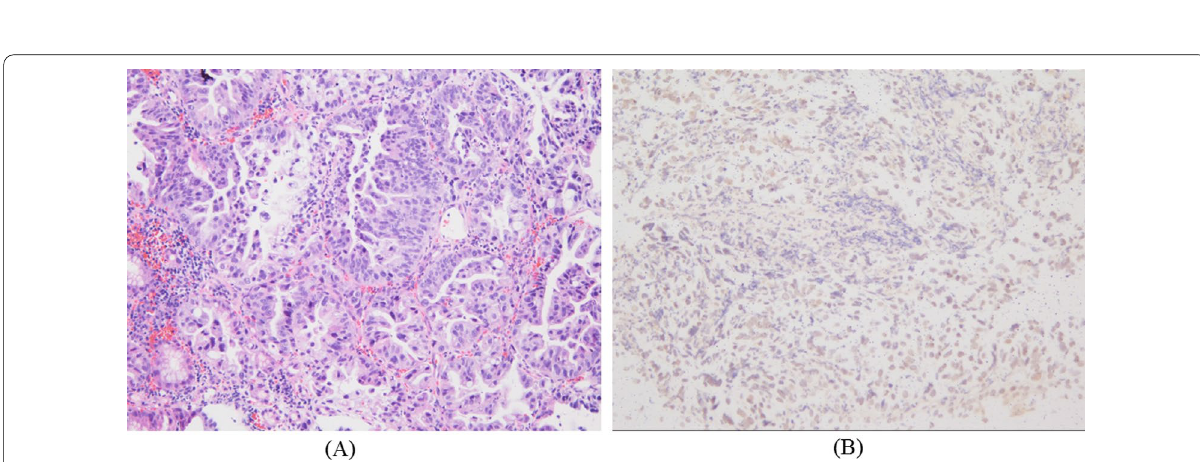
Fig. 2 A Histopathological examination revealing moderately differentiated adenocarcinoma (hematoxylin and eosin staining, Epstein–Barr virus-encoded small RNA in situ hybridization (EBIS staining,